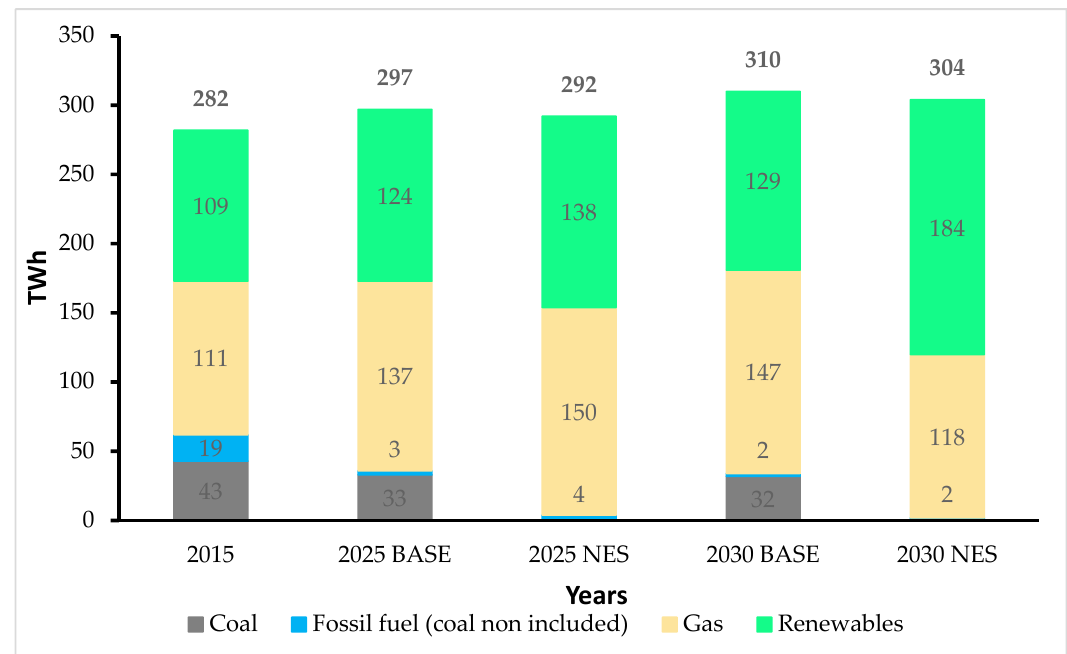
Figure 3. Outline of policy context for coal phase-out in Italy.